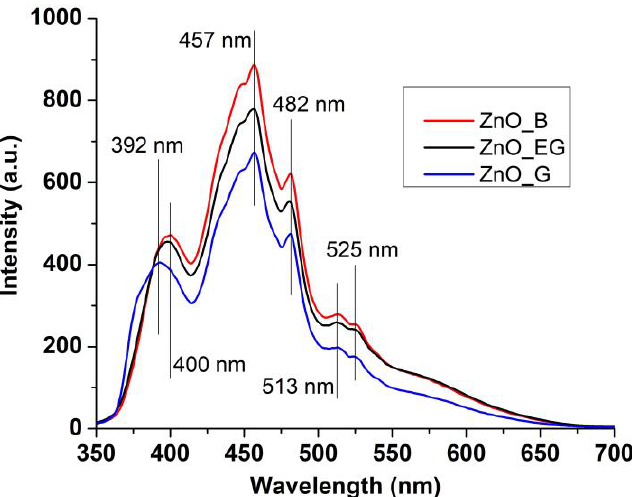
Figure 8. The emission spectra for ZnO_B, ZnO_EG and ZnO_G samples. The visible emission bands from the fluorescence spectrum of ZnO are directly